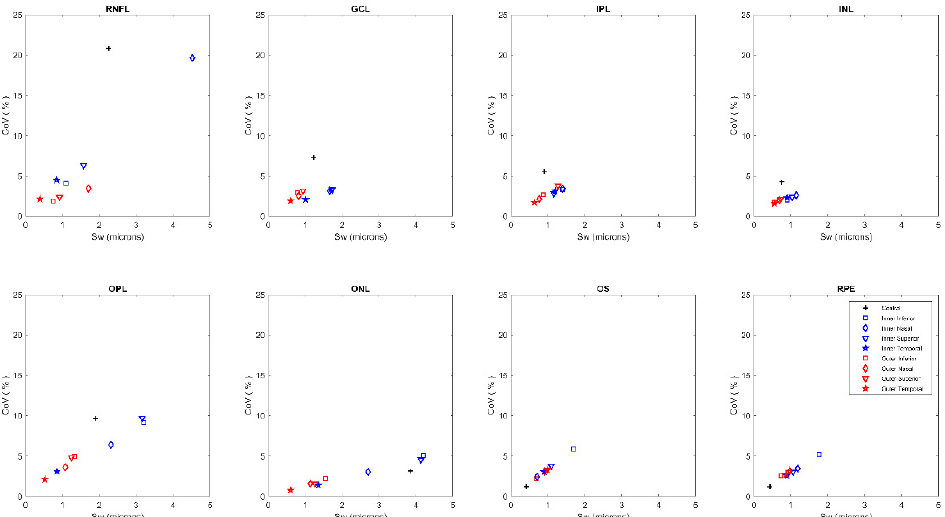
Figure 3. Relationship between the within subject standard deviation and the Coefficient of variation (CoV). Sw: Within subject standard deviation, Retinal Nerve Fiber Layer (RNFL), Ganglion Cell Layer (GCL), Inner Plexiform Layer (IPL), Inner Nuclear Layer (INL), Outer Plexiform Layer (OPL), Outer Nuclear Layer (ONL), Outer Segment (OS), and Retinal Pigment Epithelium (RPE).